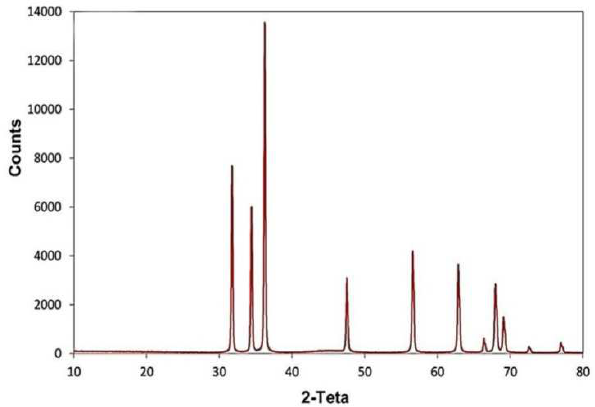
Figure 3. X-ray diffraction (XRD) spectrum of as- synthesized ZnO nanoparticles in optimal calcination conditions (Calcination temperature = 459 ºC, calcination time = 3.65